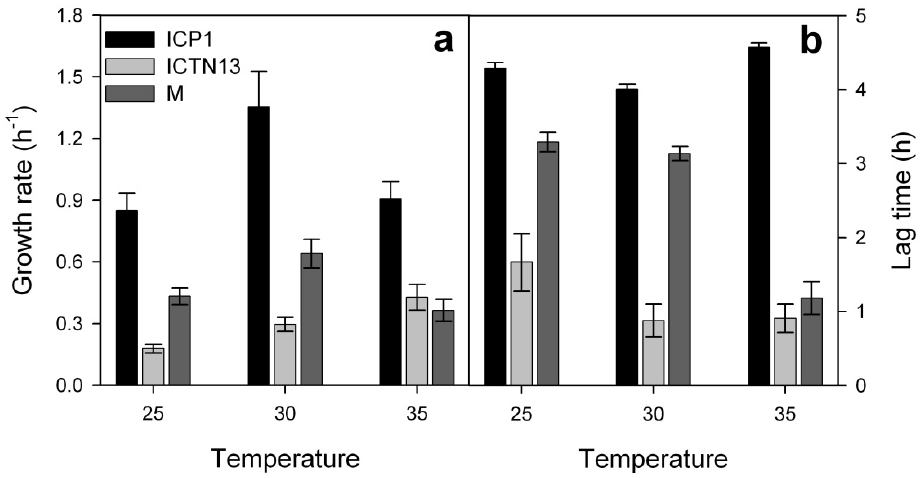
Figure 5. Growth rates ( a ) and lag-times ( b ) of the strains ICP1, ICTN13 and their mixture (M) cultivated in a minimal medium supplemented with 1.3 mM phenol and incubated at various temperatures (25, 30, and 35 °C). Error bars indicate standard deviation of the three independent experiments with three technical replicates.